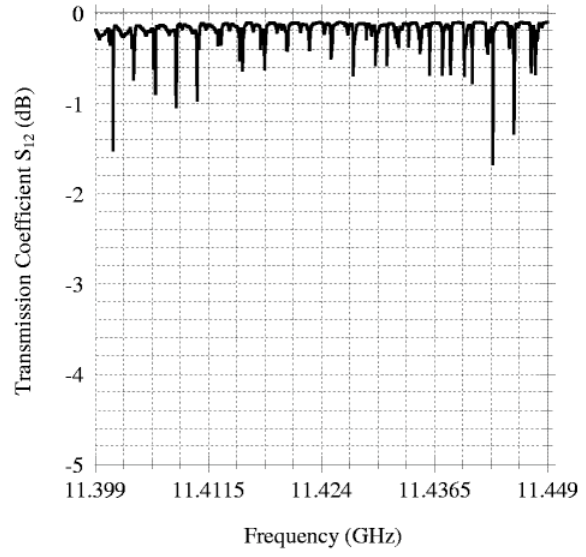
FIG. 27. Transmission through two TE 01 mode transducers, two arc tapers, and 55 m of 12.065 cm diameter circular waveguide.